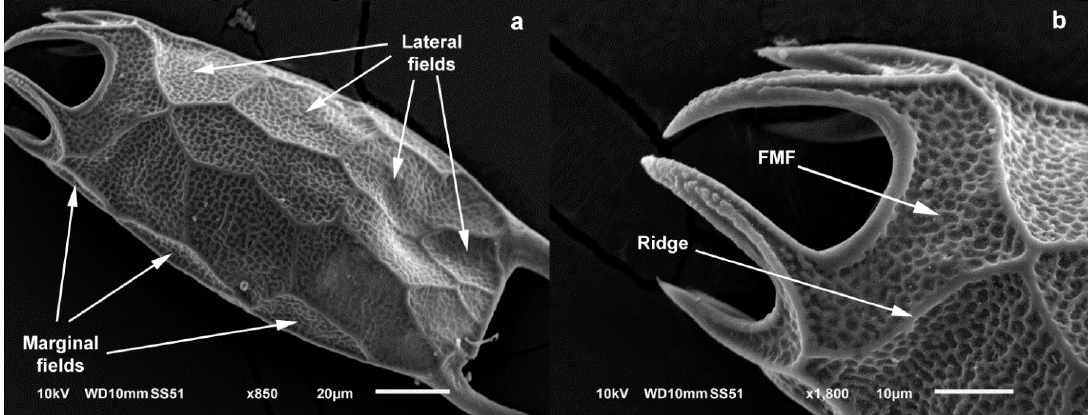
Figure 9. Morphology of Keratella cuitzeiensis sp. nov. ( a ). Dorsal view: arrows indicate the lateral and the marginal fields. ( b ). Anterior margin of the lorica in dorsal view, FMF (Frontomedian field), thin arrow indicate a ridge. Female from Cuitzeo lagoon.